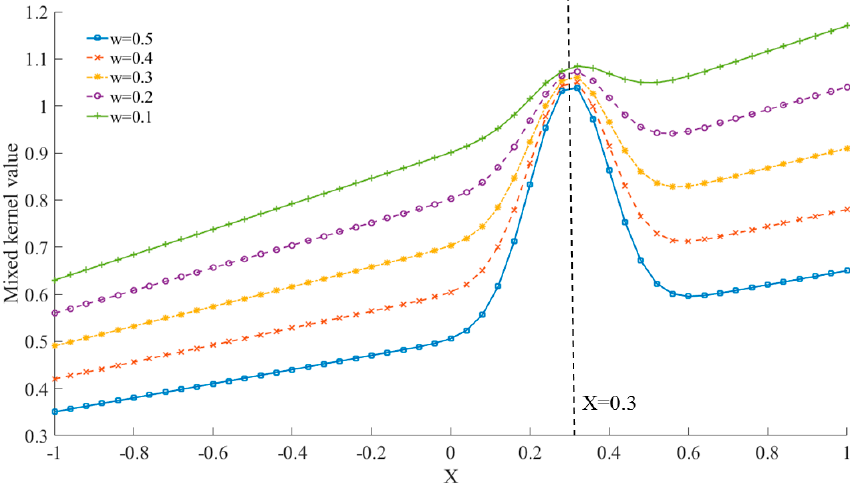
Figure 3. Data distribution of a mixed kernel (Gaussian kernel & polynomial kernel, test point X = 0.3).